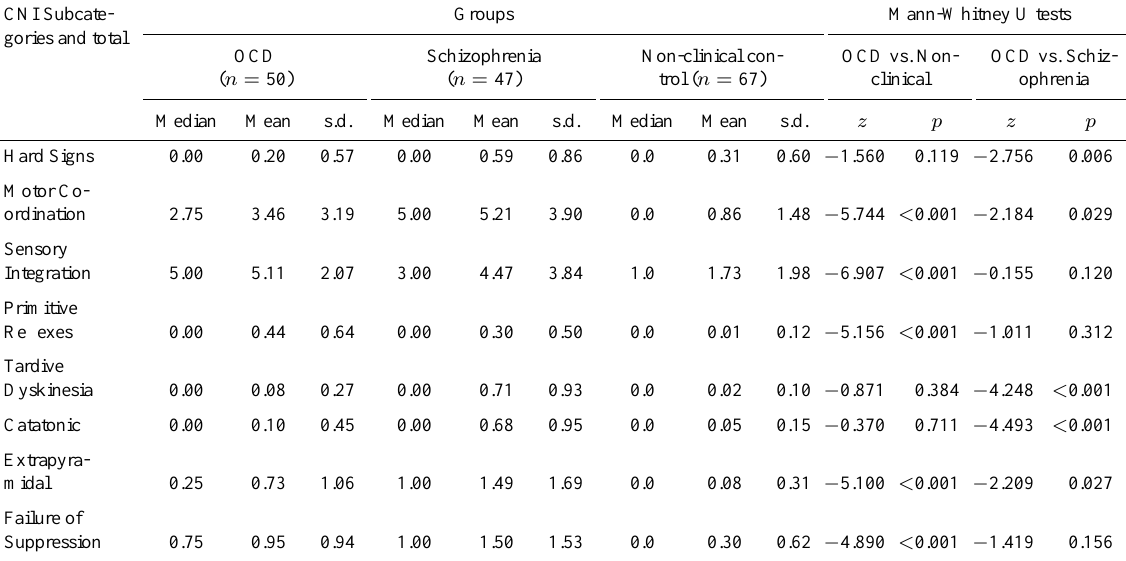
Table 2 Median and mean scores and standard deviations for CNI categories for three groups: patients with OCD and schizophrenia and non-clinical controls; Mann-Whitney U statistics and p -values for between group differences: OCD vs. Non-clinical, OCD vs.